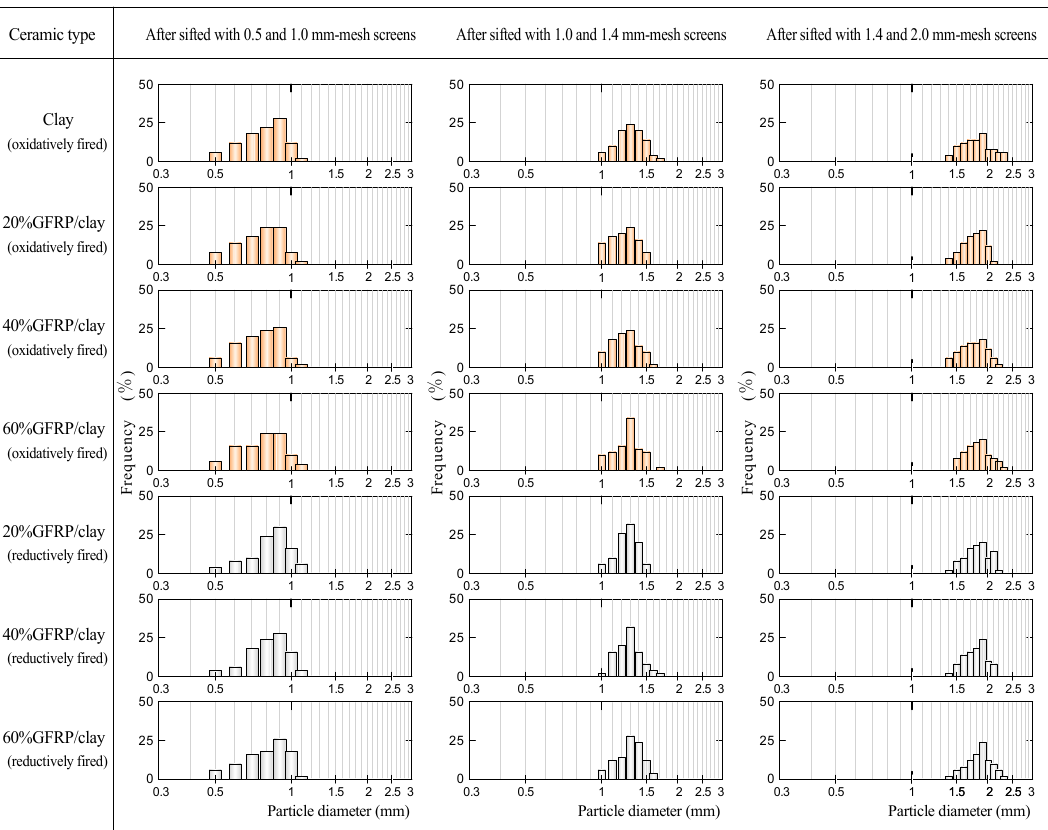
Figure 3. Particle size distribution of granular ceramics.